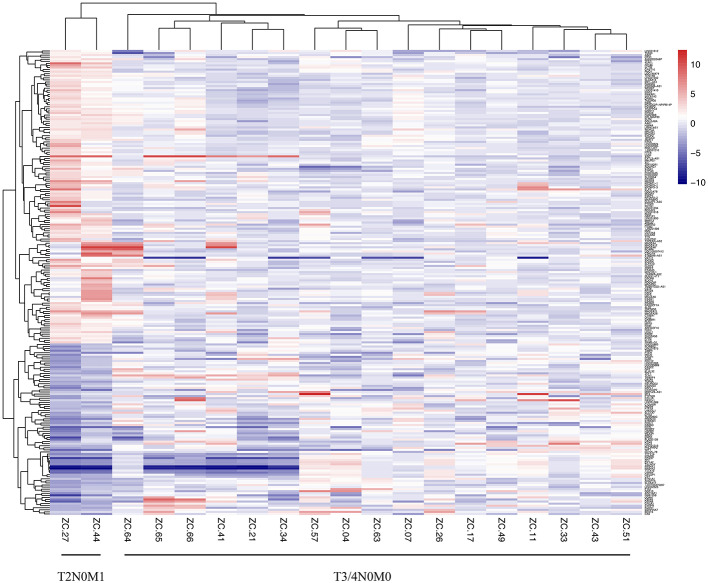
Heatmap of mRNA array of CRC patients with T2N0M1 and T3/4N0M0 samples. The mRNA profiles of the primary tumor tissues (2 samples of T2N0M1, 17 samples of T3/4N0M0) were analyzed. The heat map of mRNA array showed that there was an obvious difference between the T2N0M1 subgroup and the T3/4N0M0 subgroup.